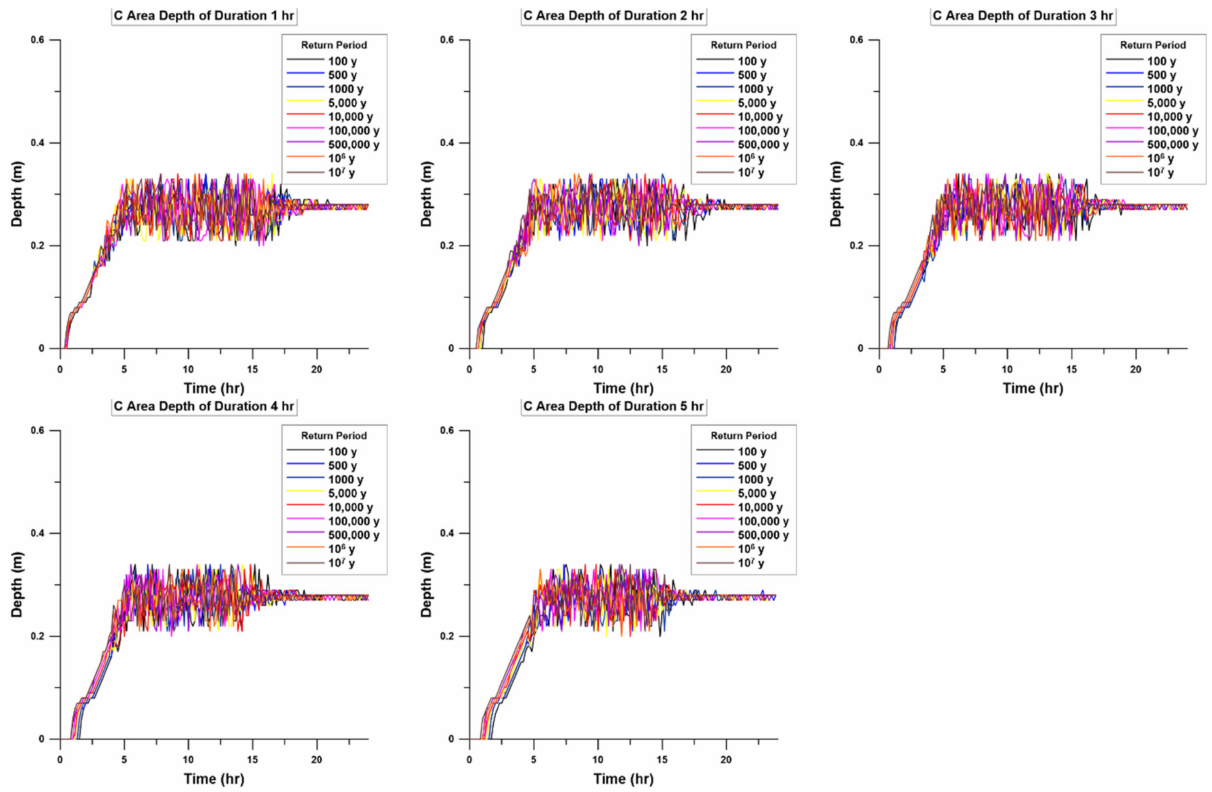
Figure 14. 2D flood depths from the 2D internal analysis results (Area C, NPP